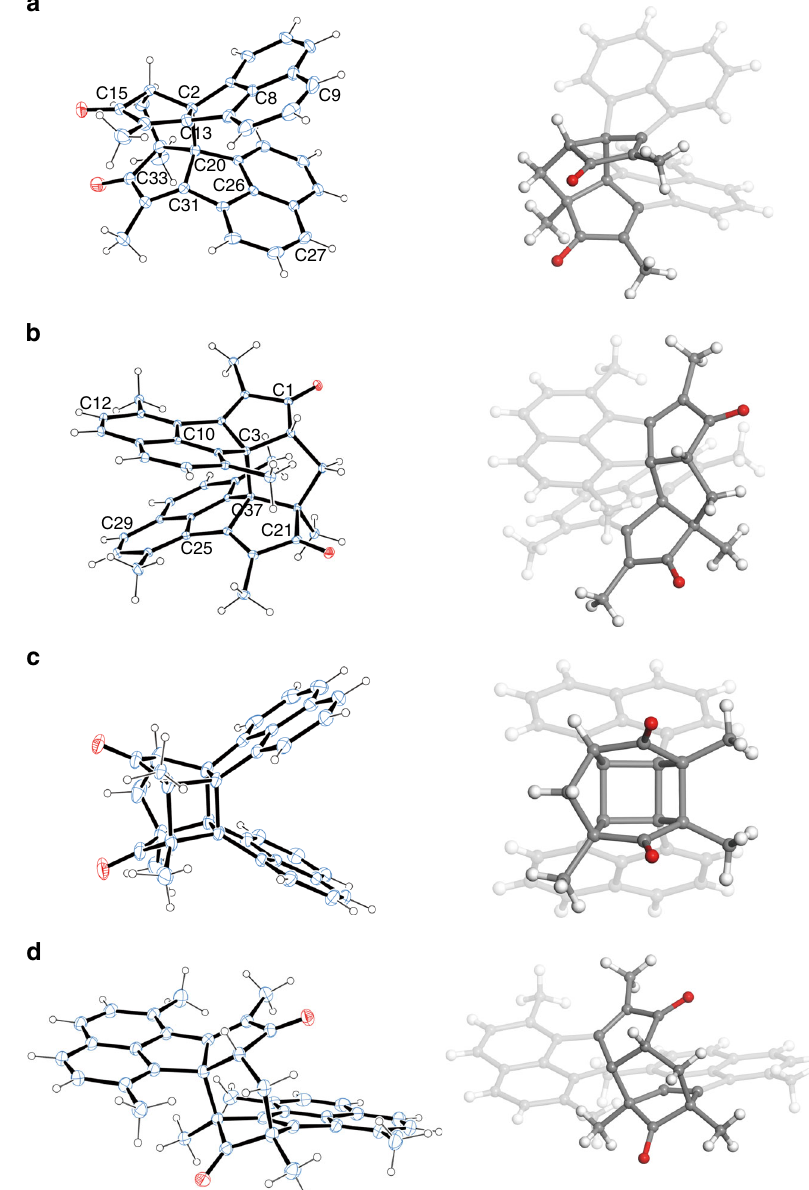
Fig. 2 Single-crystal structures. a 3a , b 3b , c 4a , and d 4b . Thermal displacement ellipsoids are shown at the 25% probability level. The annulated rings are